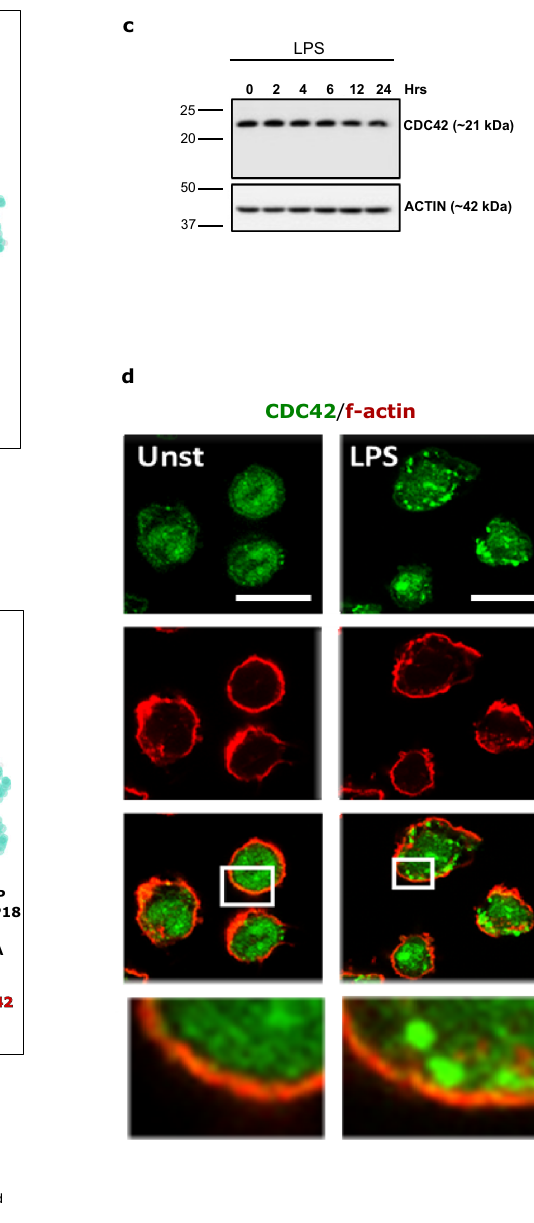
Fig. 5 Relocalisation of RHO-GTPase traf fi cking molecules to the PM. Relocalisation of RHO-GTPase family members and accessory proteins were found in response to LPS, including CDC42, RAC1, RHOA, RHOC, SRGAP2, ARHGAP18, APBB1IP. These proteins are shown in a unstimulated and b LPS- stimulated conditions. c Western blot of CDC42 in the 24 h-LPS time-course. Anti-actin western blot is shown as control. Molecular weight markers are indicated in kilodaltons (kDa). d Confocal image (×63) of THP-1 cells ± LPS for 12 h and labelled with anti-CDC42 (Green) and phalloidin (Red). Scale bar = 10 µ m. All western blots and images were conducted at n = 1. Source data are provided as a Source Data fi